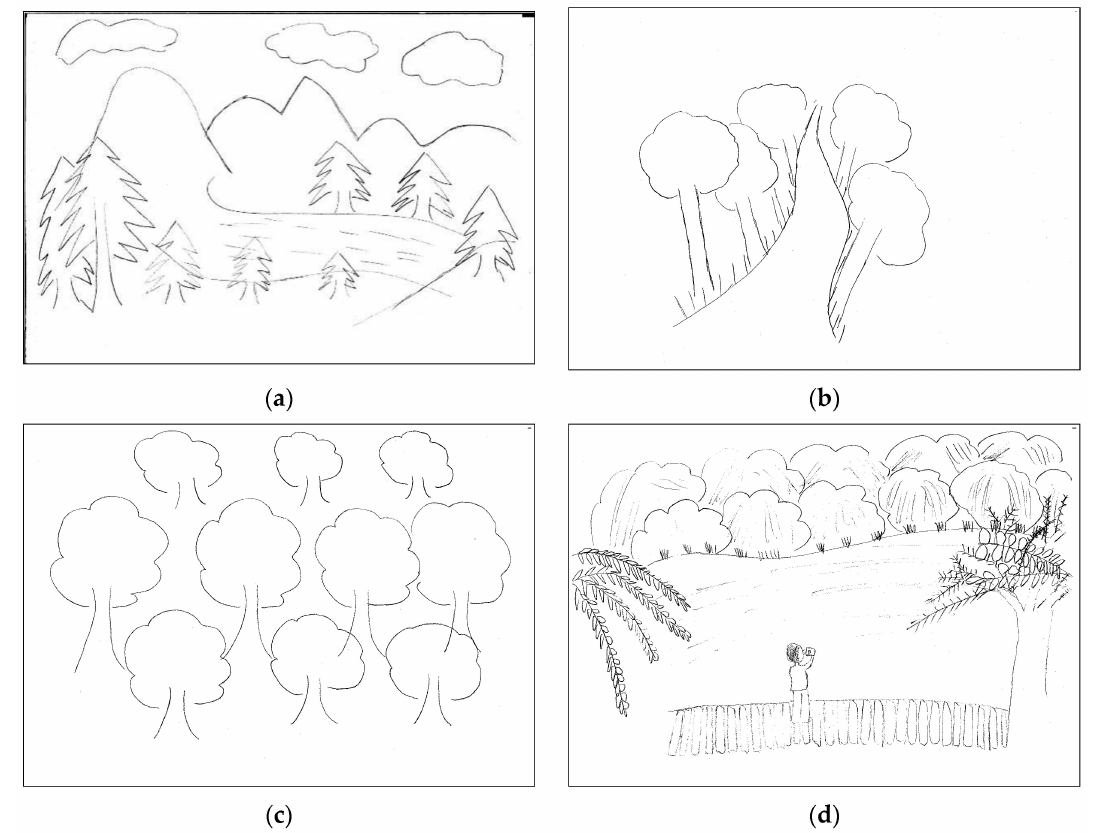
Figure 4. Classification of the self-orientation: ( a ) objective scene; ( b ) surrounding place; ( c ) single object; ( d ) scenic